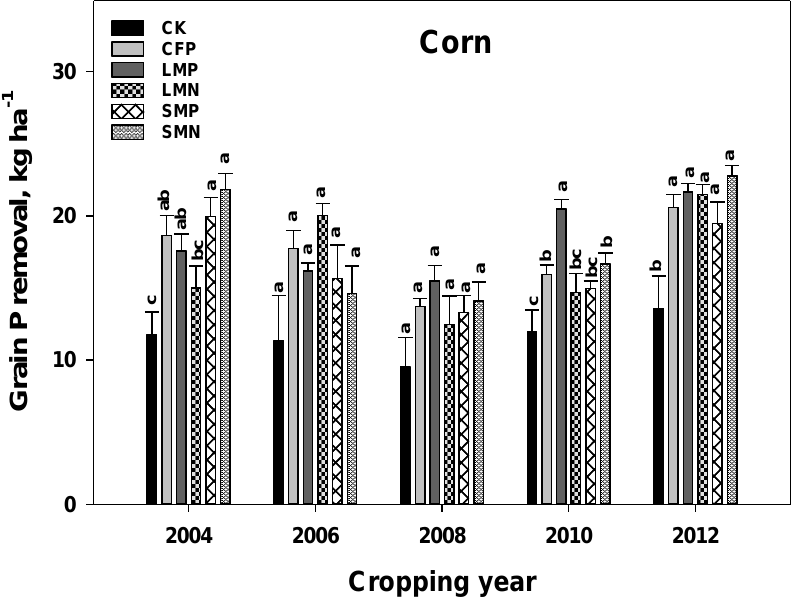
Figure 4. Effects of cropping year and source of P addition (chemical fertilizer vs. liquid and solid Scheme 10. year time period, 2004–2013, in a Brookston clay loam soils, Woodslee, ON, Canada. CK, no-P control; CFP, chemical fertilizer P; LMP, P-based liquid swine addition; LMN, N-based liquid swine manure addition; SMP, P-based solid swine manure addition; SMN, N-based solid swine manure addition. Error bar is the standard error of the mean ( n = 3). The different letters over the bars indicate significant differences at the p ≤ 0.05 level. Table 4. Responses of above-ground-P uptake for corn and soybean to various sources of P addition (chemical fertilizer vs. liquid and solid swine manures) and application approaches (P-based vs. N-based) over a 10-year time period, 2004–2013, under a corn-soybean rotation in a clay loam soil, Woodslee, ON, Canada.